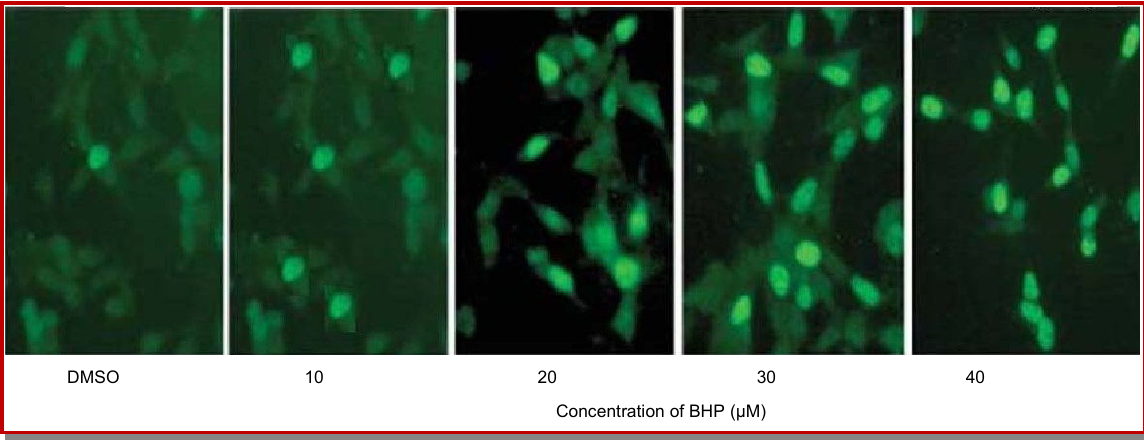
Figure 2 : BHP treatment induces apoptosis in PC3 prostate carcinoma cells. PC3 cells after incubation with BHP or DMSO as con- trol for 48 hours were stained using annexin V-FITC and propidium iodide. The fluorescence microscopy was used for the visuali- zation of apoptotic